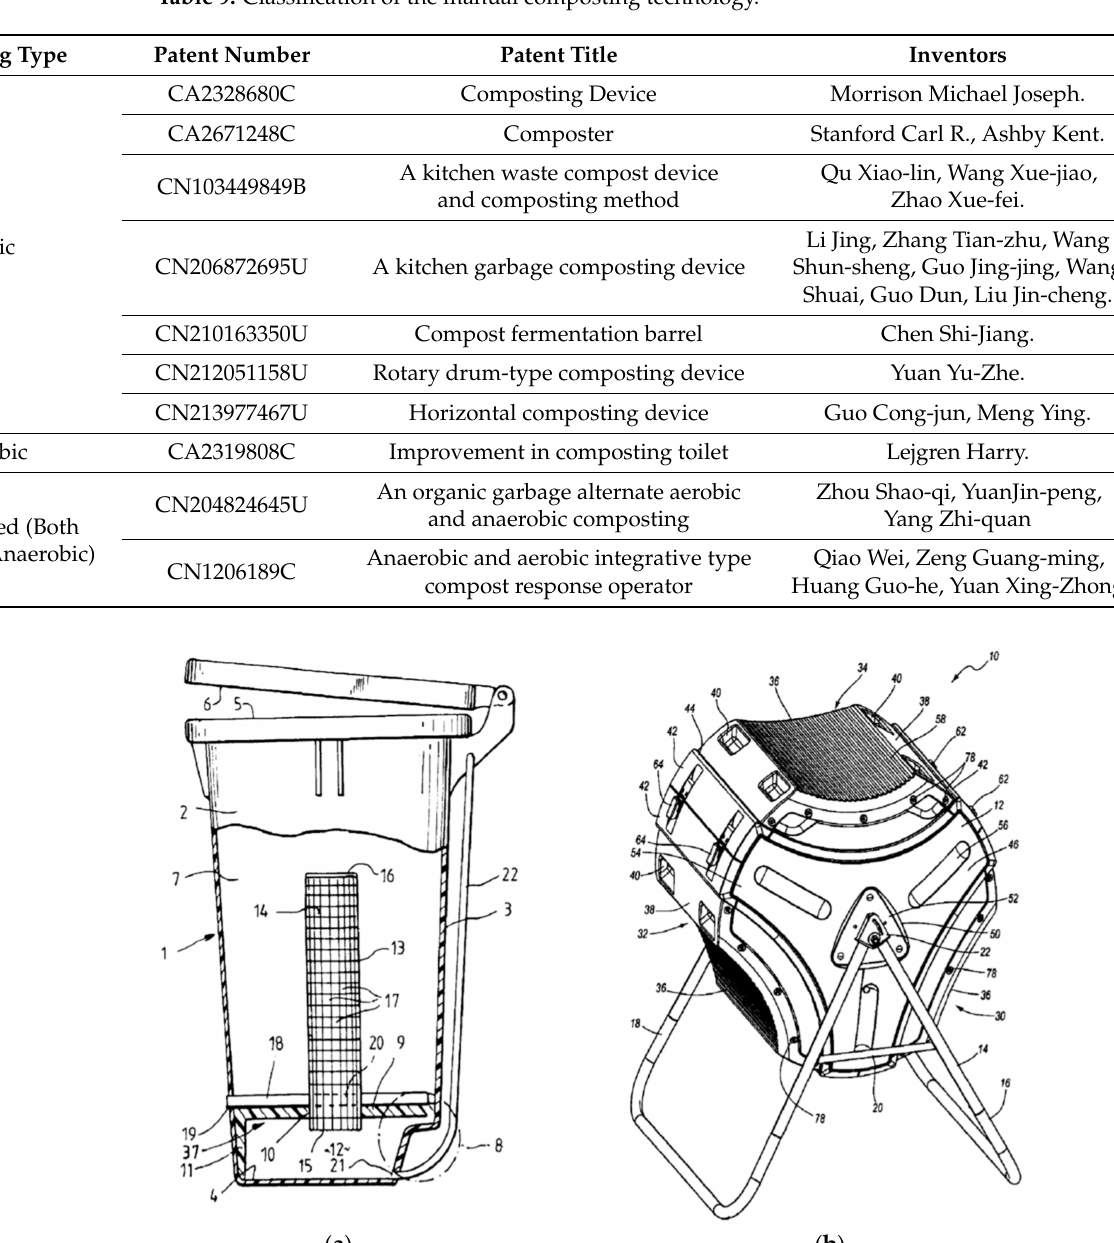
Table 9. Classification of the manual composting technology.